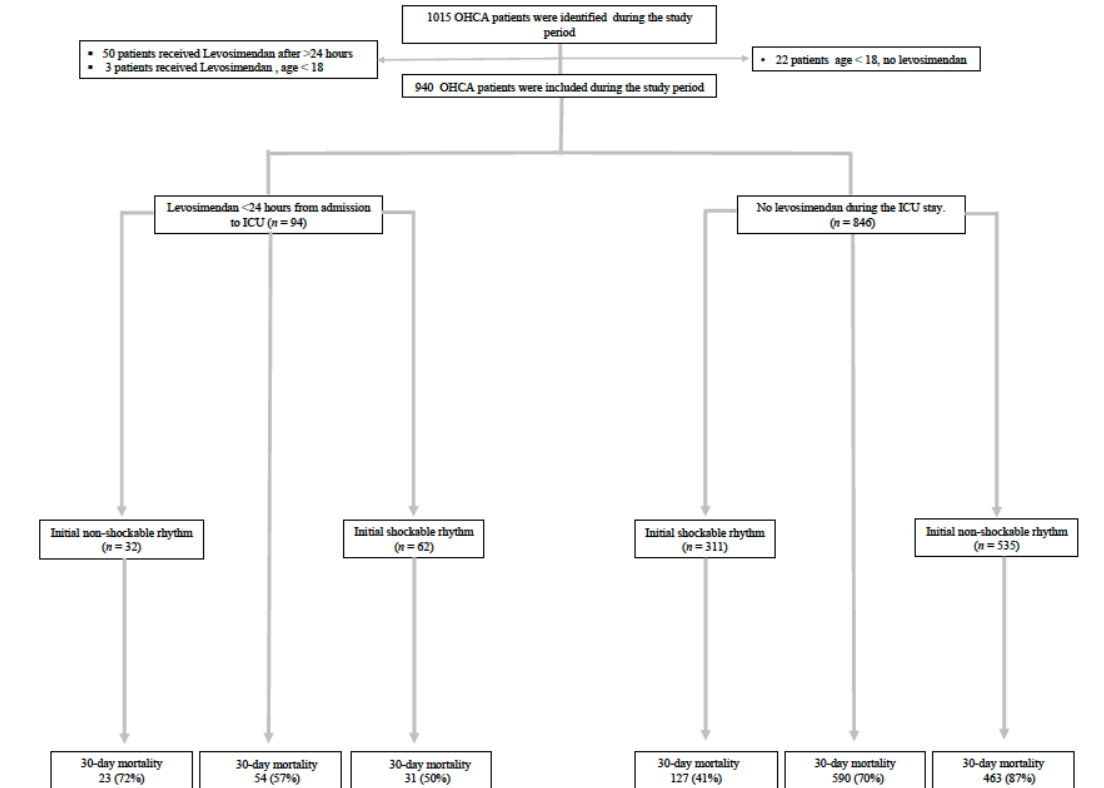
Figure 1. The CONSORT Flow Diagram of out-of hospital cardiac arrest patients admitted to the ICU in Stockholm, Sweden, 2010–2016. Abbreviations: OHCA = out-of-hospital-cardiac arrest; ICU = intensive care unit. Table 1. Baseline characteristics in out-of-hospital-cardiac arrest patients admitted to the intensive care unit in Stockholm, Sweden,